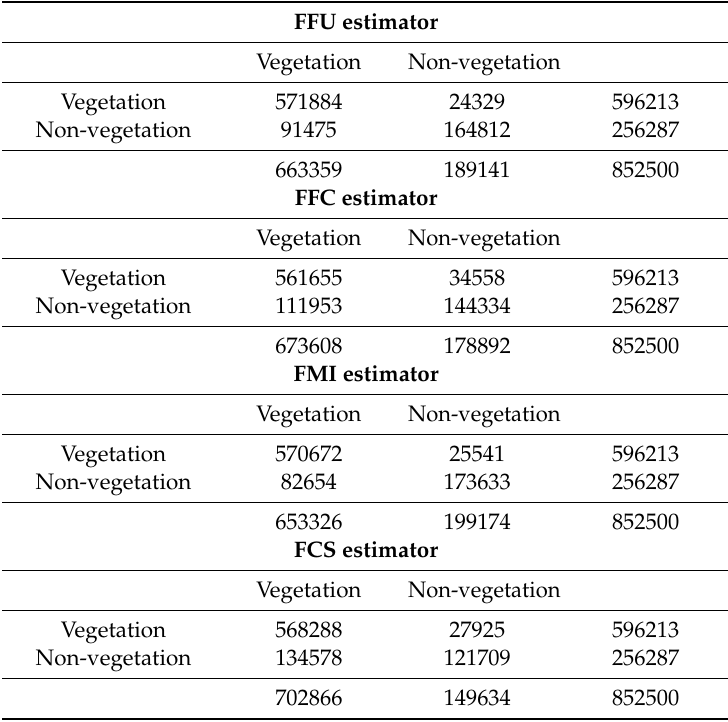
Table 1. Cross-tabulation of confusion matrices corresponding to vegetation areas detected from four estimators and reference data.